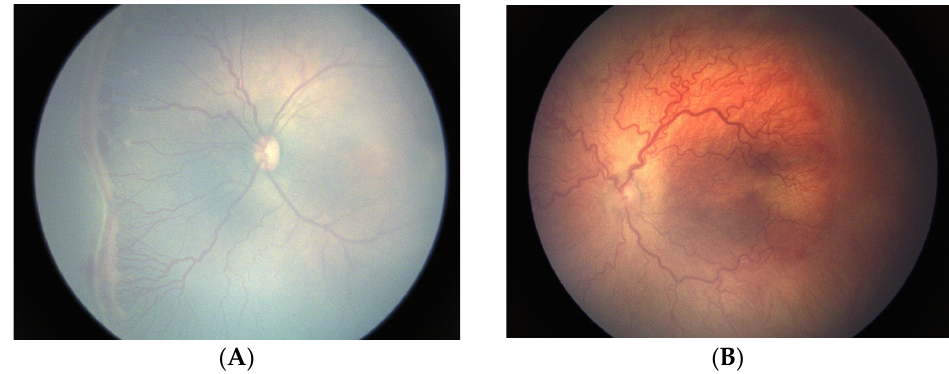
Figure 1. Patients with typical retinopathy of prematurity (ROP) requiring treatment (Type 1 ROP) in a neonatal intensive care unit with modern strict oxygen regulation. ( A ) Preterm infant with gestational age of 26 weeks and birthweight of 600 g, who developed stage 3 ROP in zone I (Type 1 ROP) at 38 weeks’ post-menstrual age. Notice the traditional stage 3 ROP, characterized by extraretinal neovascular proliferation. ( B ) Fundus photograph of a baby born at 24 weeks and a birthweight of 710 g with very severe bronchopulmonary dysplasia. As pictured at 34 weeks’ post-menstrual age, note the deceptively featureless networks of flat neovascularization in the setting of severe plus disease and aggressive ROP (A-ROP).